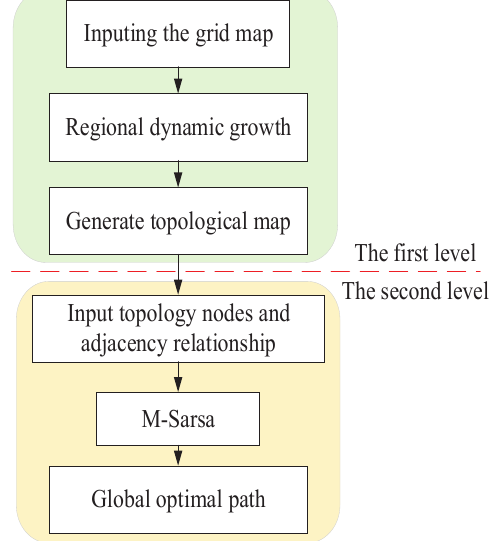
Figure 2. The framework of the proposed